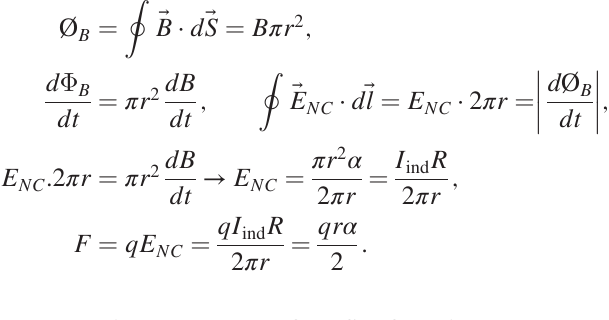
Fig. 9. The ammeter G registers a current. Explain in detail why a current appears in the coil.